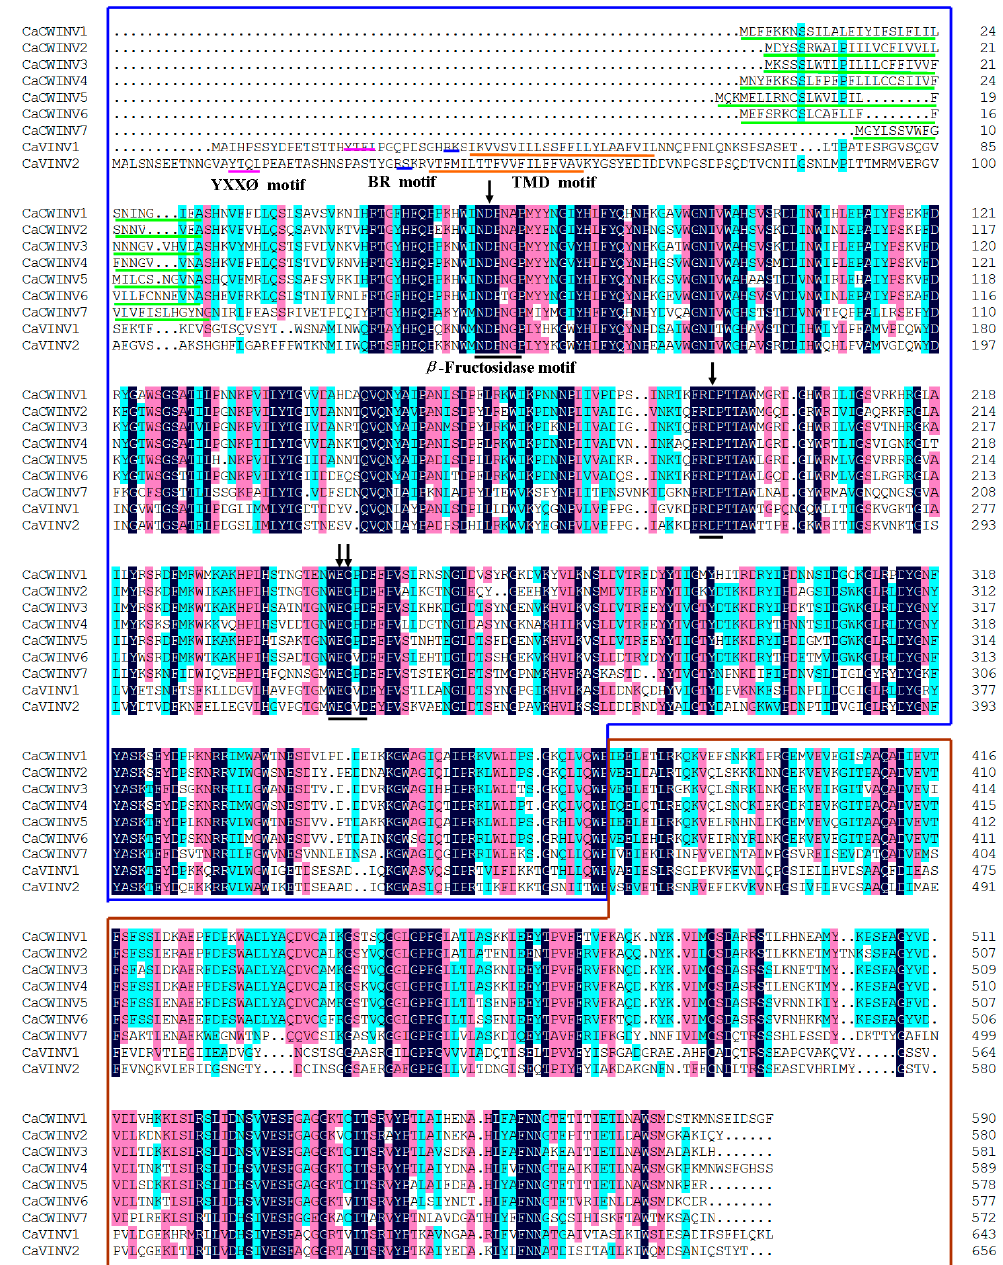
Figure 1. Alignment of deduced amino acid sequences of the nine pepper acid invertases. Dark-blue shading, pink shading, and light blue shading reflect 100%, 75%, and 50% amino acid residues conservation, respectively. Catalytic residues are depicted by black arrows. Green lines indicate the predicted signal peptide. Black lines indicate the conserved motif-NDPNG ( β -fructosidase motif), RDP and WECP(V)D. Brown lines indicate the predicted transmembrane domain (TMD). The blue lines indicate basic region (BR) motif. The pink lines indicate YXXØ motif.